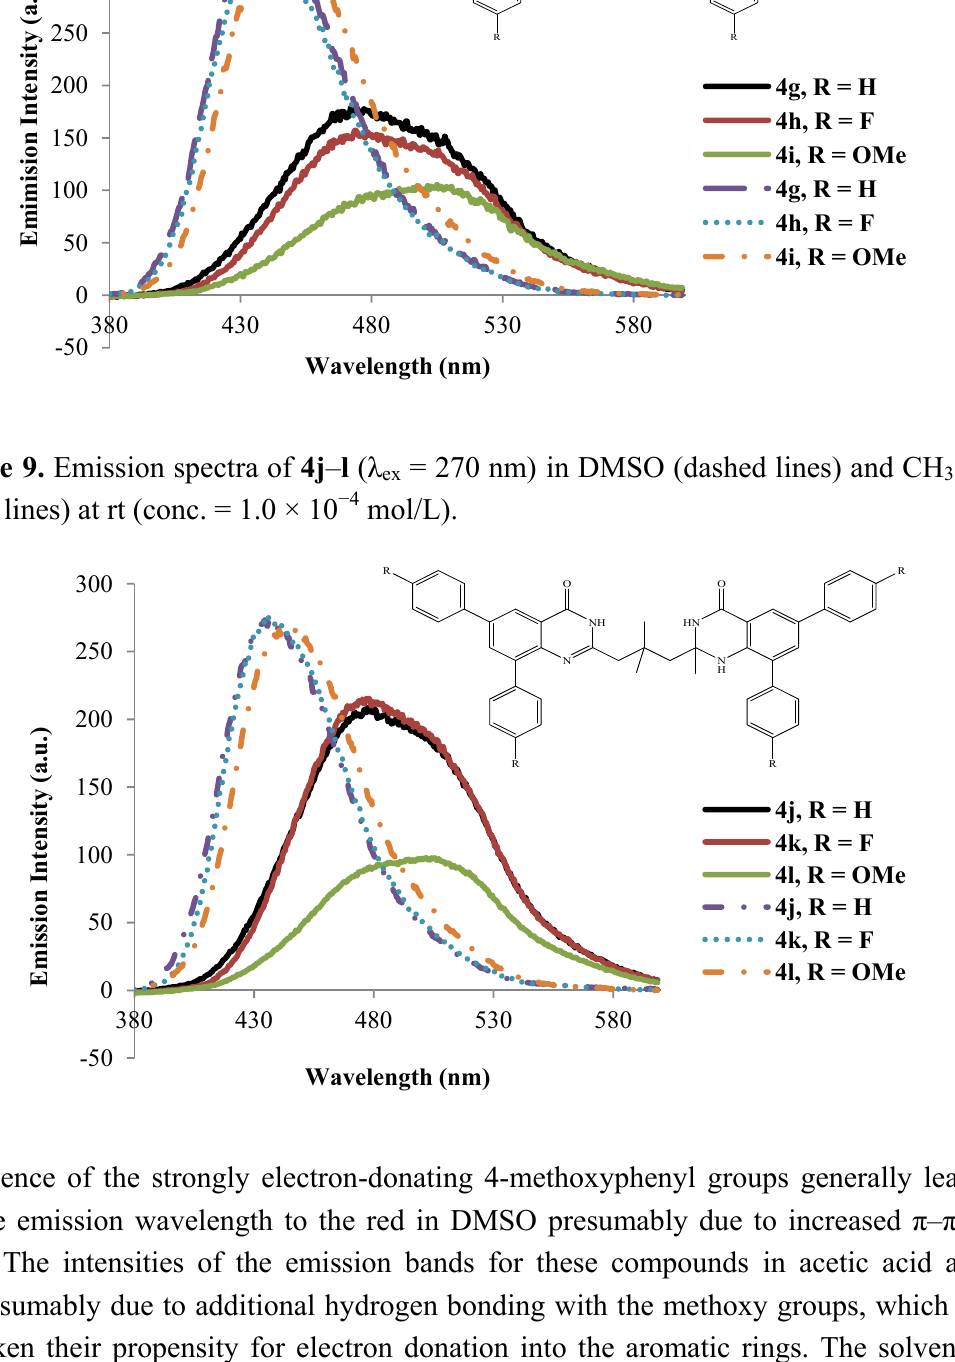
Figure 8. Emission spectra of 4g – i ( λ (solid lines) at rt (conc. = 1.0 × 10 − 4 mol/L).